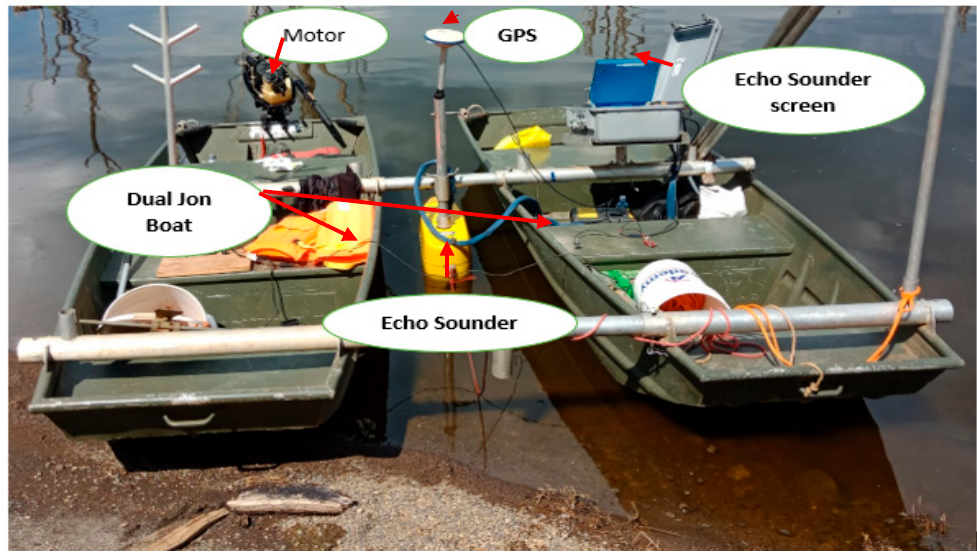
Figure 2. Bathymetry survey equipment set up.